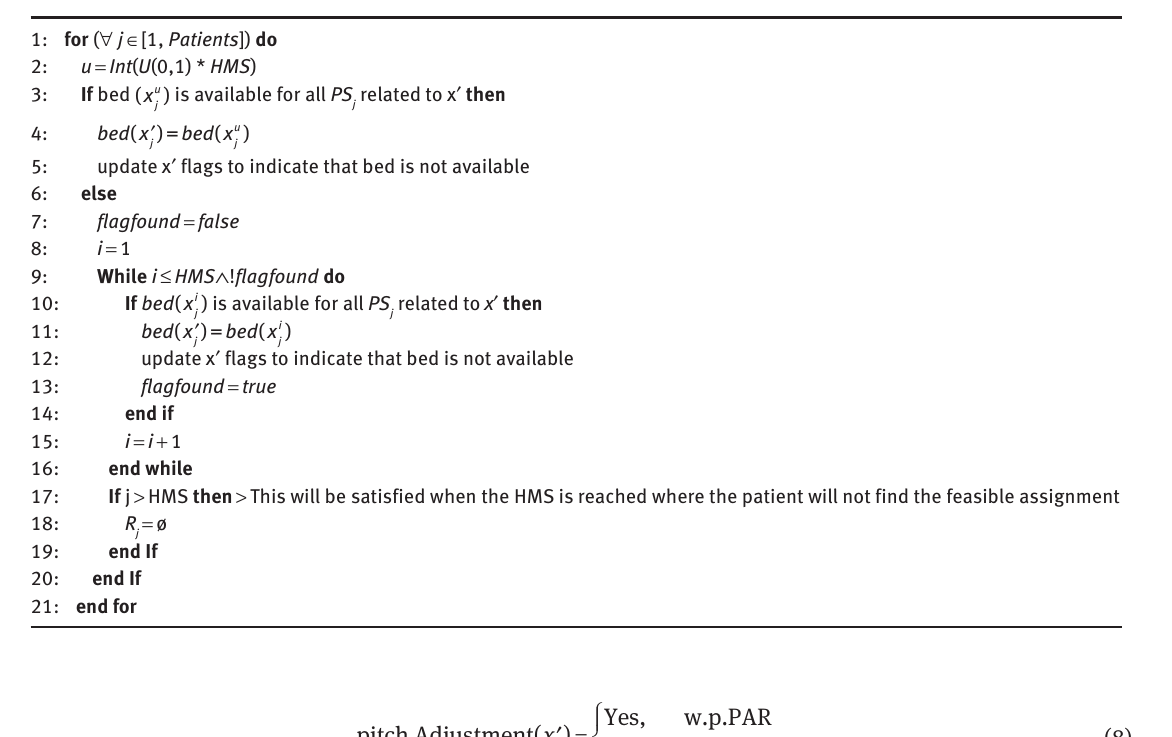
from the solutions stored in the j